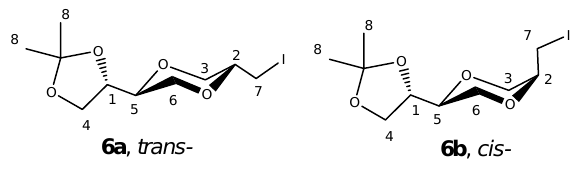
Figure 6. Molecular structures 6a and 6b